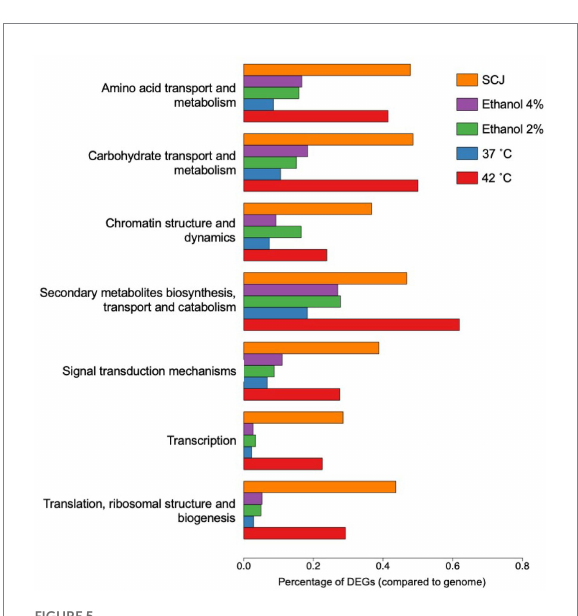
FIGURE 5 Eukaryotic orthologous groups (KOG) selected for TFBS finding. Percentage of DEGs compared to the total number of genes in the R. toruloides genome for each condition are shown as annotated using KOG. These are the most relevant conditions with the greatest amount of DEGs and were selected for further analysis. The remaining KOG annotations are shown in Supplementary Figure